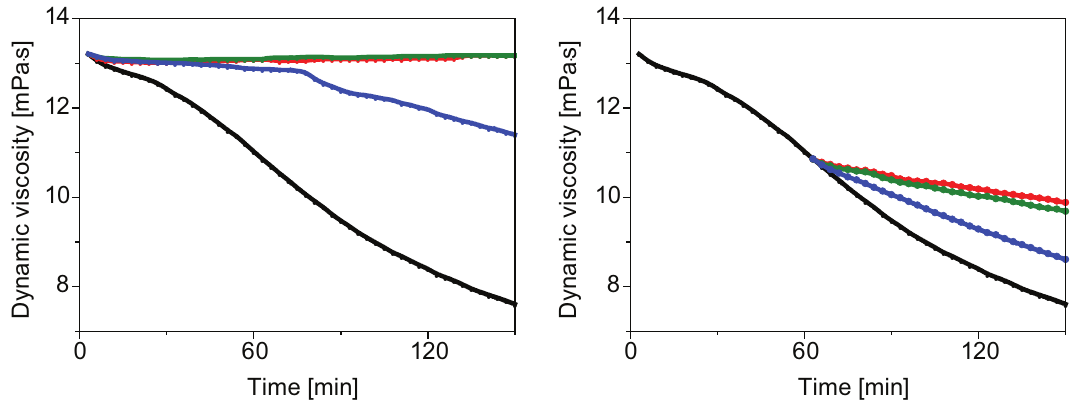
Figure 3. Time-dependent changes in dynamic viscosity of HA solutions exposed to oxidative degradation initiated by Cu(II) ions and ascorbate (black curve). Cemtirestat was added to the reaction mixture before HA degradation begins (left panel) or 1 h later (right panel) at micromolar concentrations: 25 (red), 10 (green) and 1 (blue).